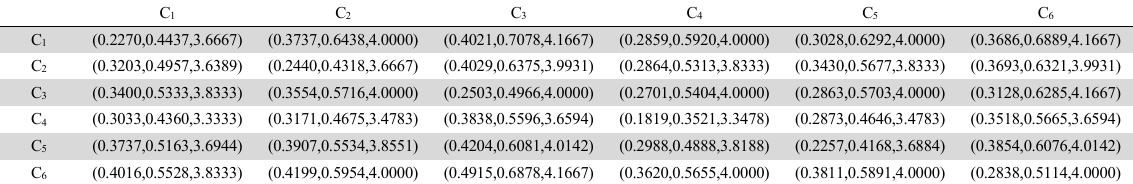
Total relationships